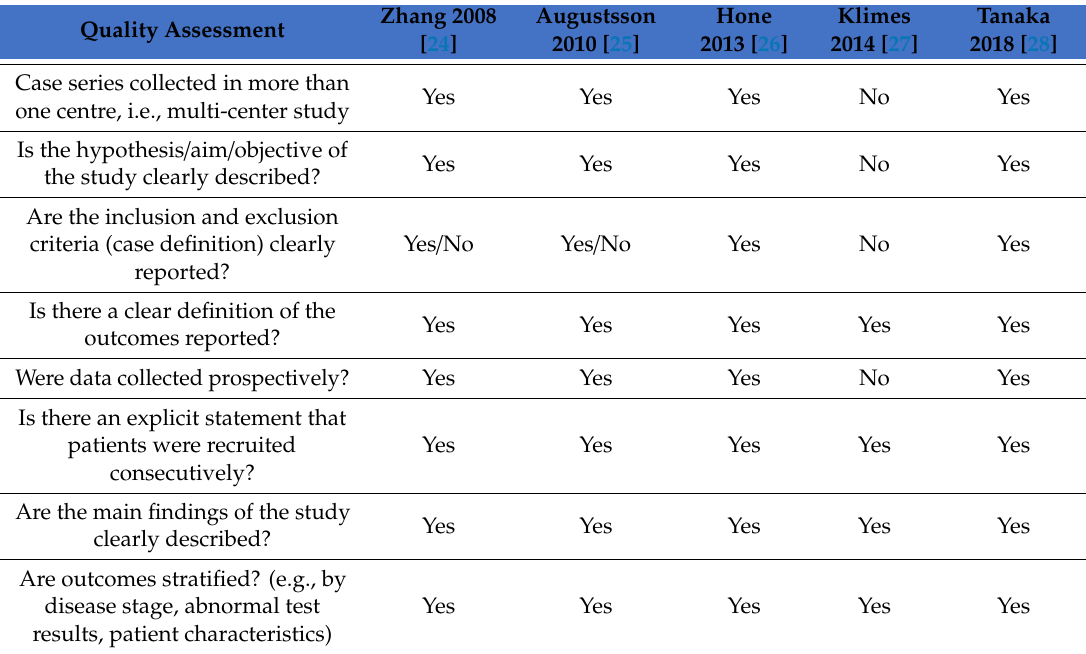
Table A3. Risk of bias in observational trials included in systematic